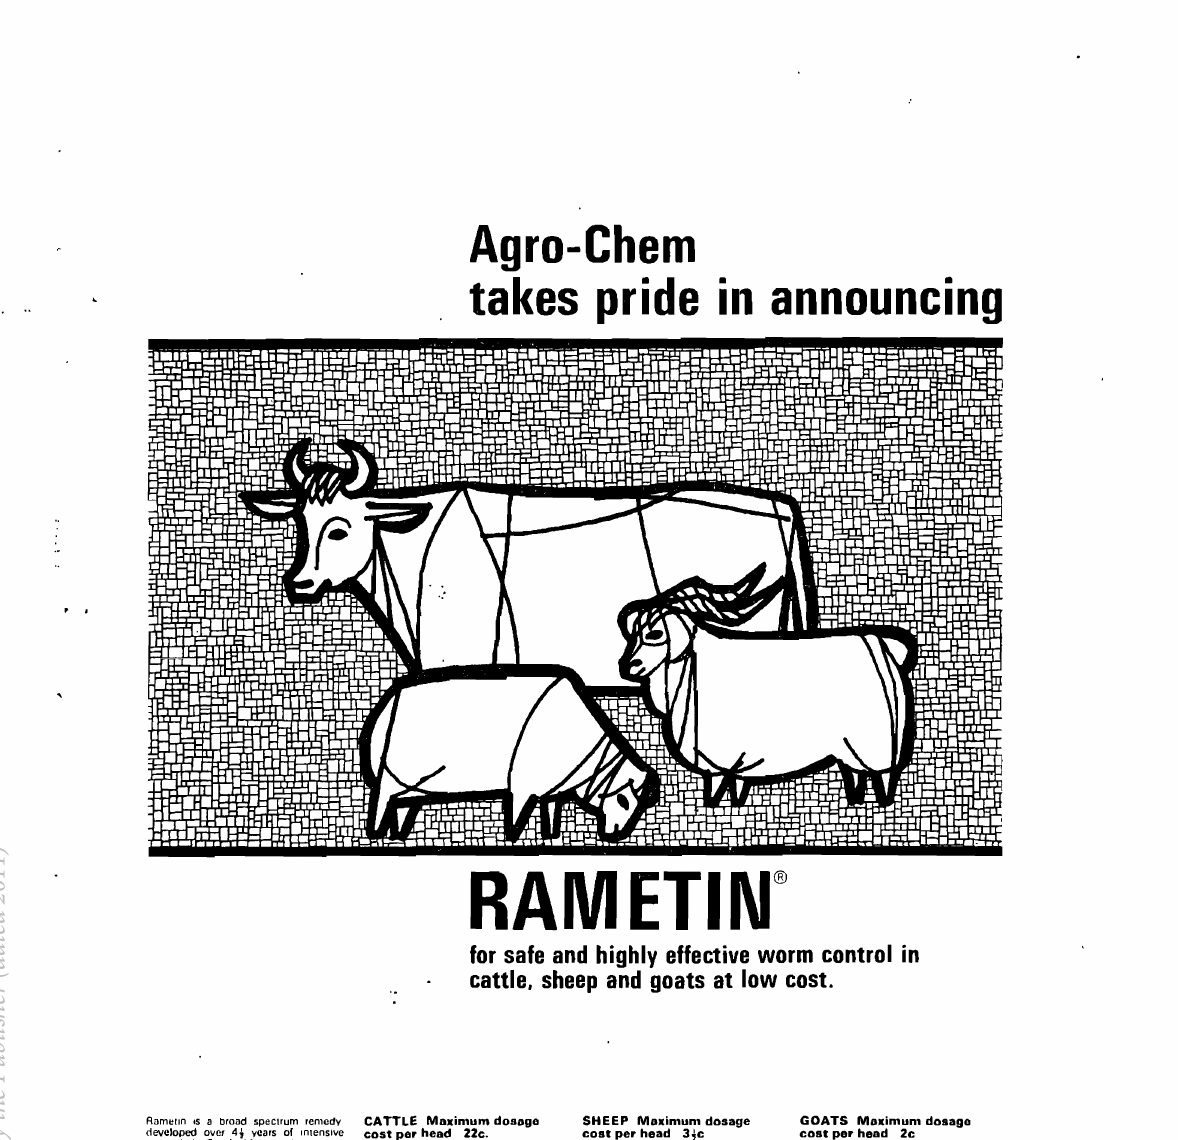
RAMETIN® for safe and highly effective worm control in cattle. sheep and goats at low